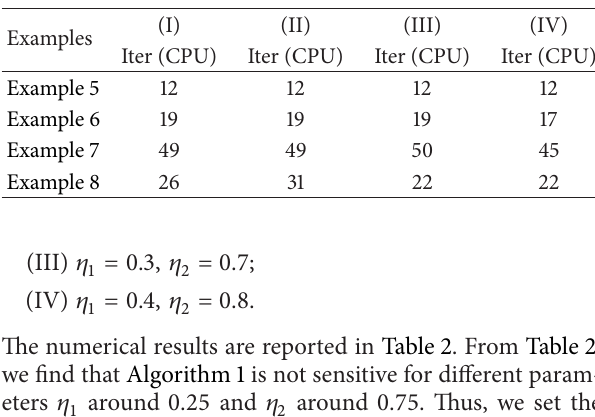
Table 2: Numerical results for different parameters of Algorithm